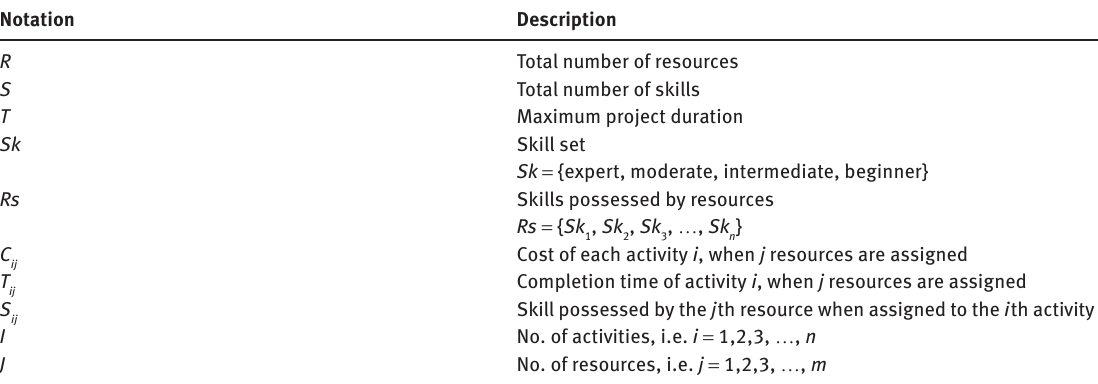
Table 1: Notations for Problem Formulation.